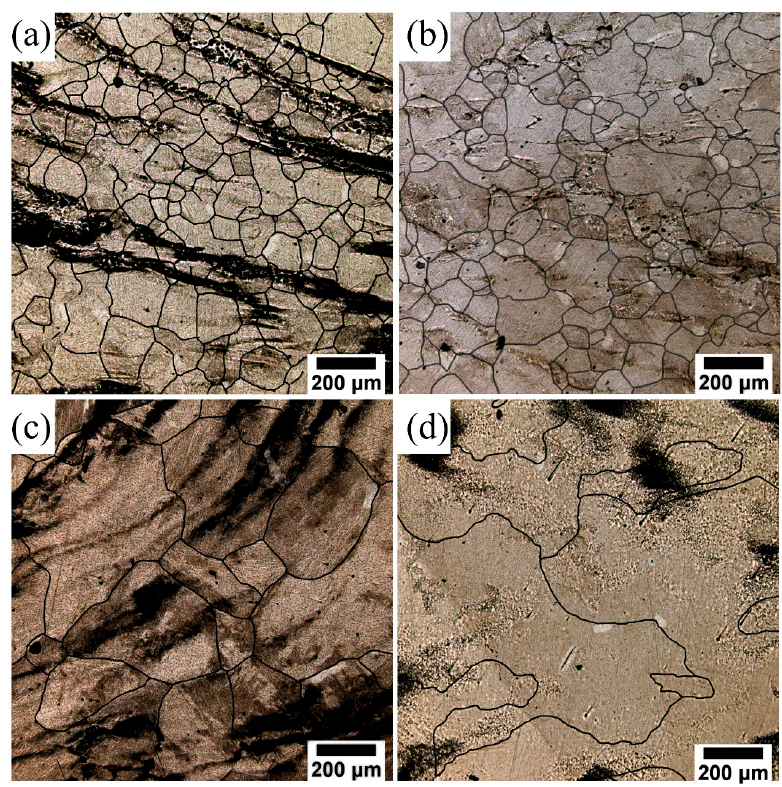
Figure 11. Austenite grain under temperature 1350 °C of ( a ) 10 s − 1 ; ( b ) 1 s − 1 ; ( c ) 0.1 s − 1 ; and ( d ) 0.01 s − 1 .